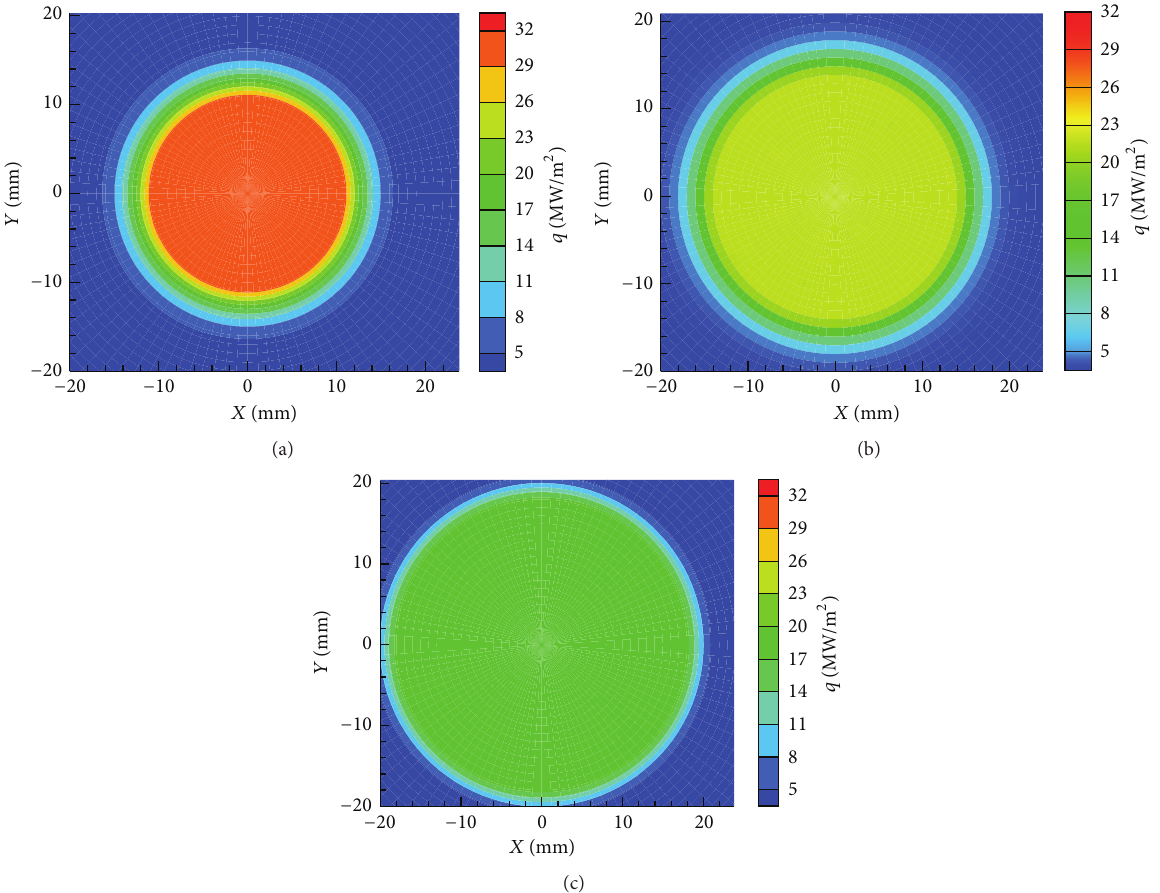
Figure 1: Radiation flux distribution in focal plane with different focal lengths: (a) 2500 mm; (b) 3250 mm; (c) 4000 mm.